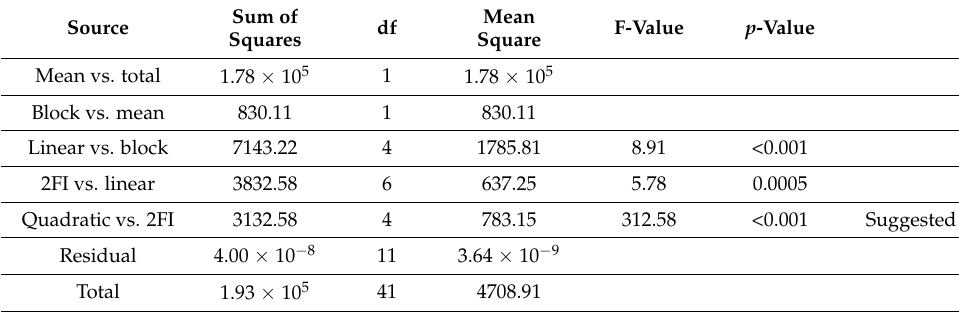
Table 6. The sequential model sum for solketal synthesis using crude